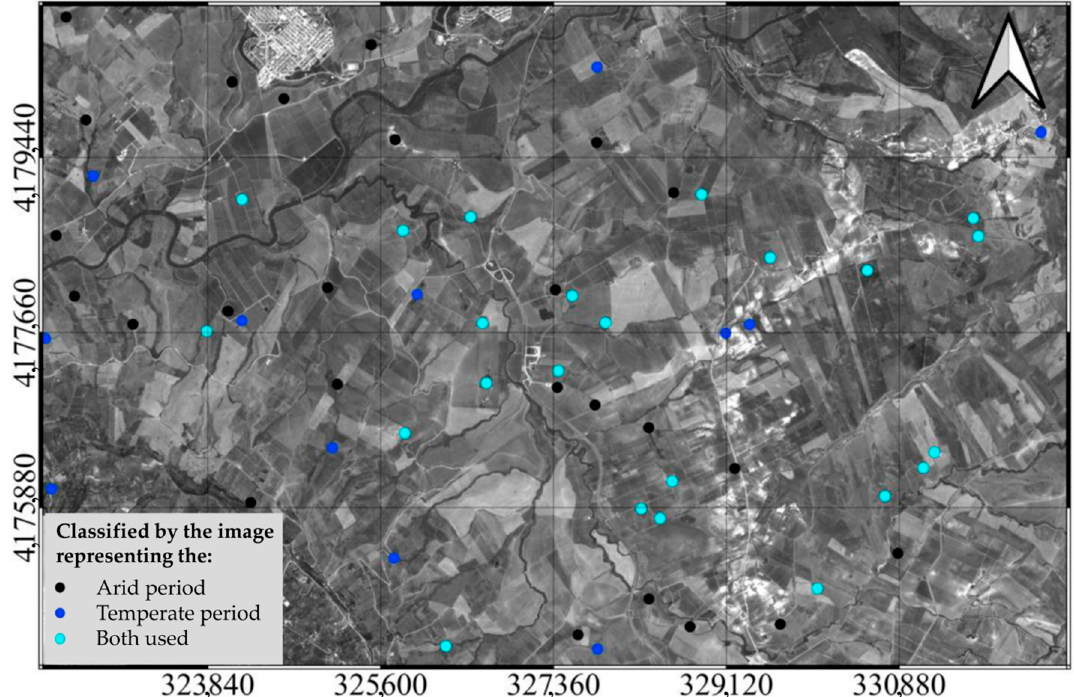
Figure 11. Spatial distribution of the hill lakes in the pilot area resulting from the segmentation-classification process. Cyan points represent lakes identified both from the images representing the arid and temperate periods; black points identify lakes classified only in the arid period; blue points identify lakes classified only in the temperate one.